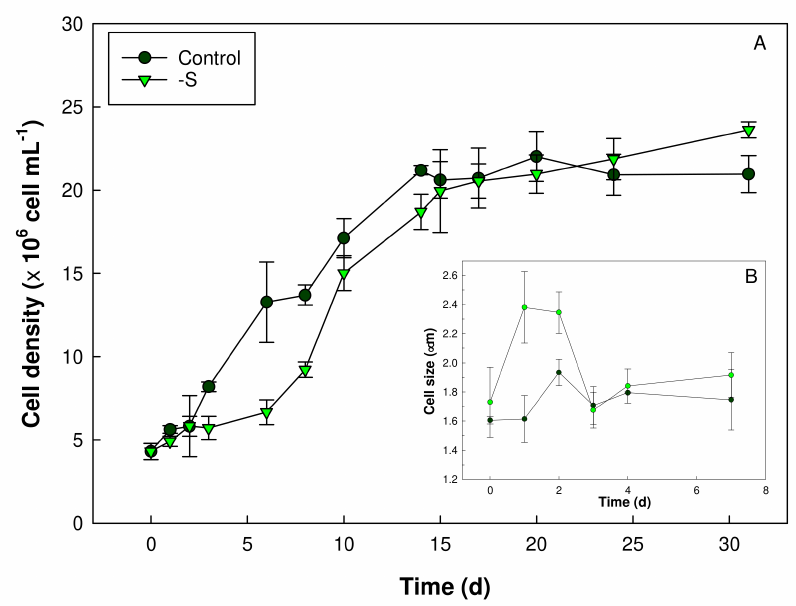
Figure 1. Cell density ( A ) and average cell diameter ( B ) of Galdieria sulphuraria grown in a complete (control) and a S deprived (-S) medium. The cell number and size were determined by a Countess II FL Automated Cell Counter (Thermo Fisher Scientific). The number of cells was assessed for a period of 30 days. The cell size was measured for 7 days. Error bars represent SD ( n =